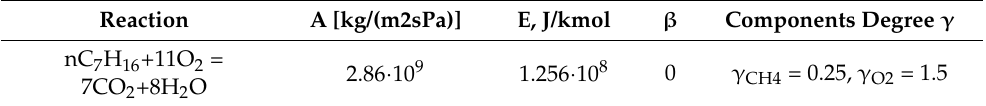
Table 2. Global 1-stage mechanism.